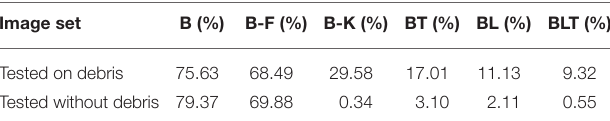
TABLE 3 | Classification error for all of the models on single digit detection when trained on heavy debris and tested without debris. Image